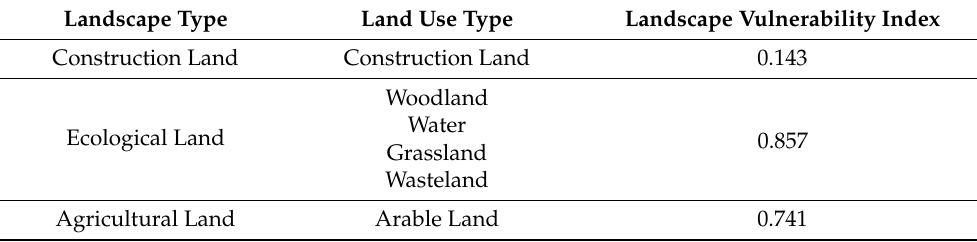
Table 5. The Landscape Vulnerability